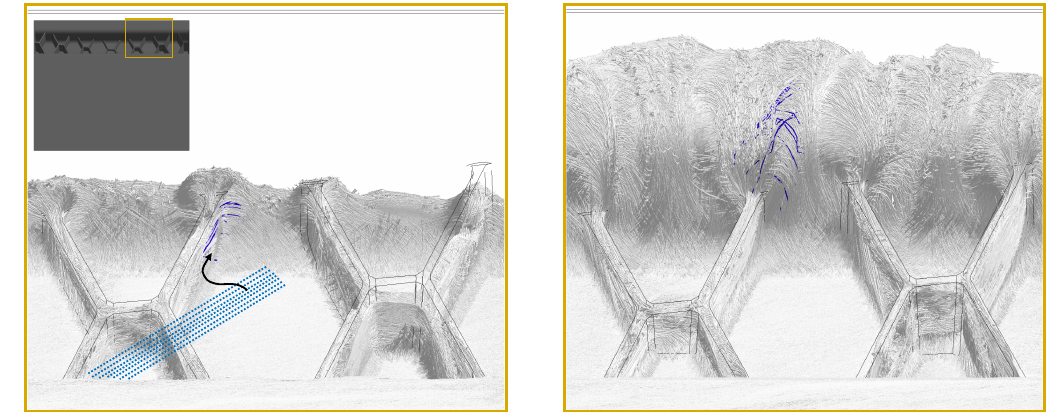
Figure 19. Virtual UD strand (colored in blue; initial position blue dotted) in the hat profile area deforming and splitting after flowing into and through a rib shown at two different time steps (all other fibers are colored in light gray).